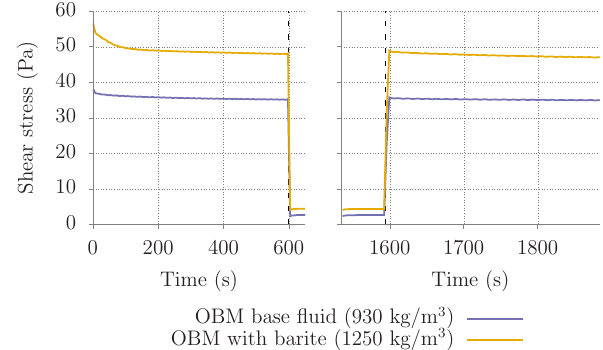
Figure 12: Measured shear stresses at a high shear rate of 1021 s −1 followed by a step change in shear rate to 5.1 s −1 (left), and the reverse step sequence from 5.1 s −1 to 1021 s −1 (right). The fluid is at rest at the very start of the measurement sequence ( t = 0 seconds). Measurements are shown for the unweighted water-based drilling fluid, and the same fluid with addition of weighting material (barite, BaSO 4 ) giving fluid mass density of 1250 kg/m 3